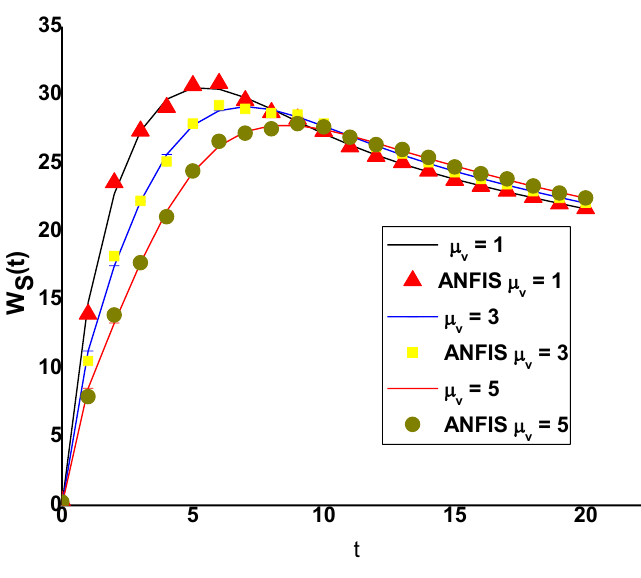
Figure 4. W S (t)vs t at various values of